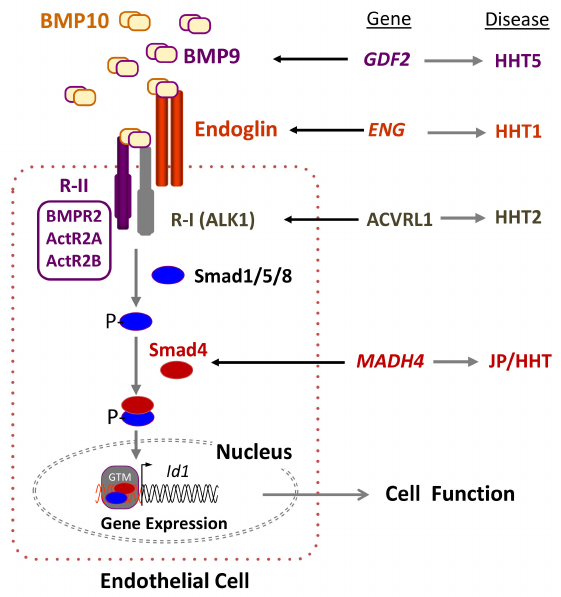
Figure 1. Hereditary hemorrhagic telangiectasia (HHT) and the transforming growth factor beta (TGF- β ) signaling pathway in endothelial cells. Heterodimers of bone morphogenetic protein 9 (BMP9) and BMP10, among other members of the TGF- β family, bind to an endothelial cell surface receptor complex composed by the type I (R-I) receptor named ALK1 and the type II (R-II; BMPR2, ActR2A, ActR2B) receptor, both serine / threonine kinases, as well as the auxiliary receptor endoglin. The heterodimeric association between di ff erent R-I and R-II determines the specificity of the ligand signaling. Upon ligand binding, the R-II transphosphorylates ALK1, which subsequently propagates the signal by phosphorylating the receptor-regulated Smad (R-Smad) family of proteins, Smad1 / 5 / 8. Once phosphorylated (P-), R-Smads form heteromeric complexes with a cooperating homologue named Smad4 and translocate into the nucleus, where they regulate the transcriptional activity of di ff erent target genes, in turn modulating endothelial cell function. The involvement of other components of the TGF- β pathway has been omitted for simplification [32]. BMP9, Endoglin, ALK1, and Smad4 proteins are encoded by GDF2 , ENG , ACVRL1 , and MADH4 genes, whose pathogenic mutations give rise to HHT5, HHT1, HHT2, and JPHT, respectively. BMP, bone morphogenetic protein; GTM, general transcription machinery. Adapted from Ruiz-Llorente et al.